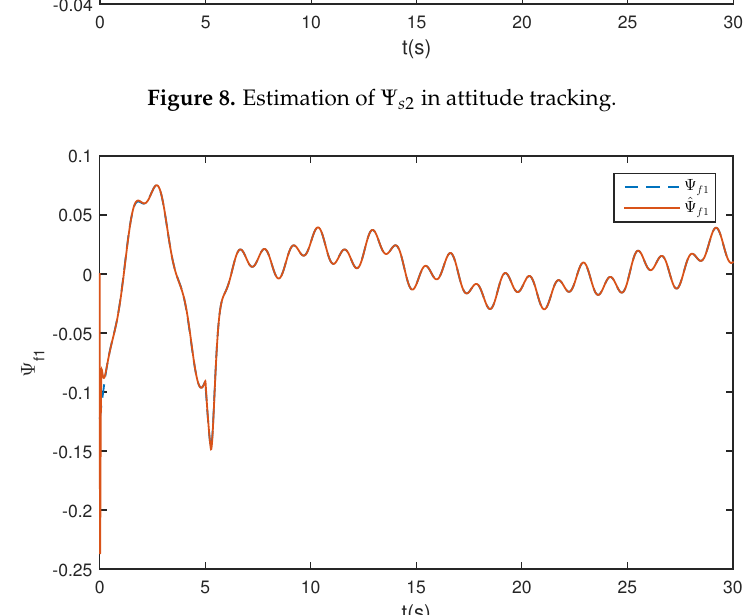
Figure 9. Estimation of Ψ f 1 in attitude